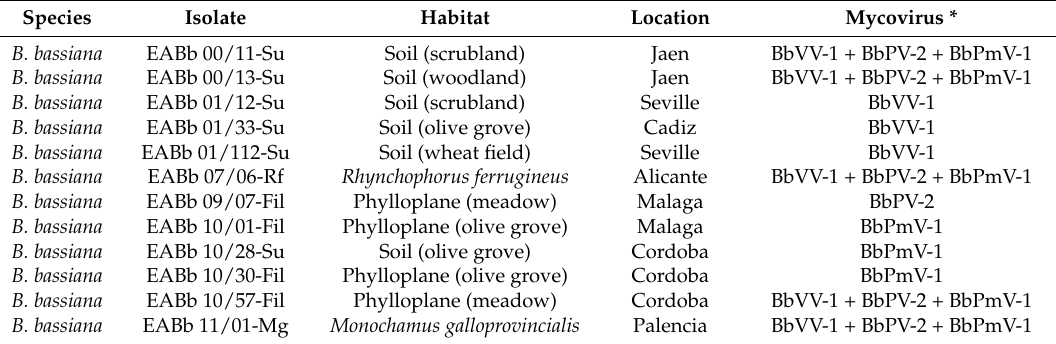
Table 1. Mycovirus-infected B. bassiana isolates, their habitat and Spanish